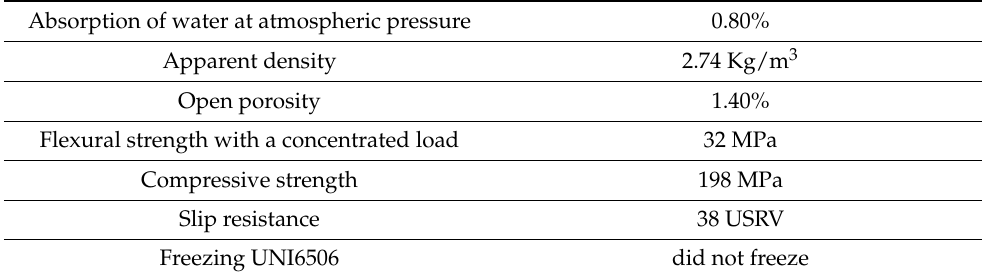
Table 2. Technical features of Pietraforte